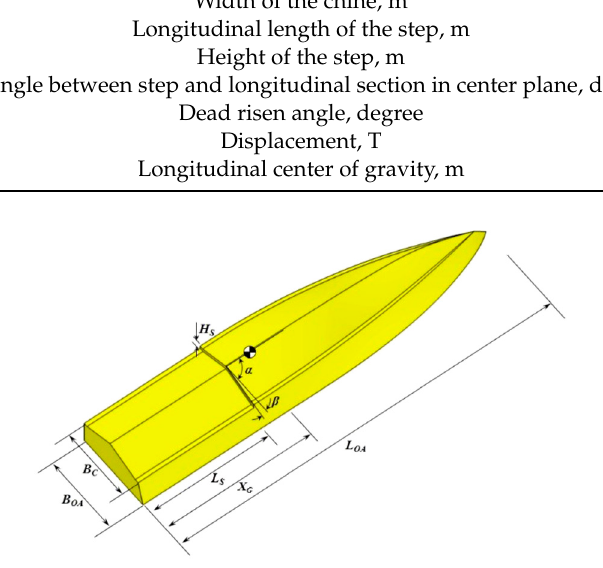
Figure 1. Single stepped planing hull in Taunton series.